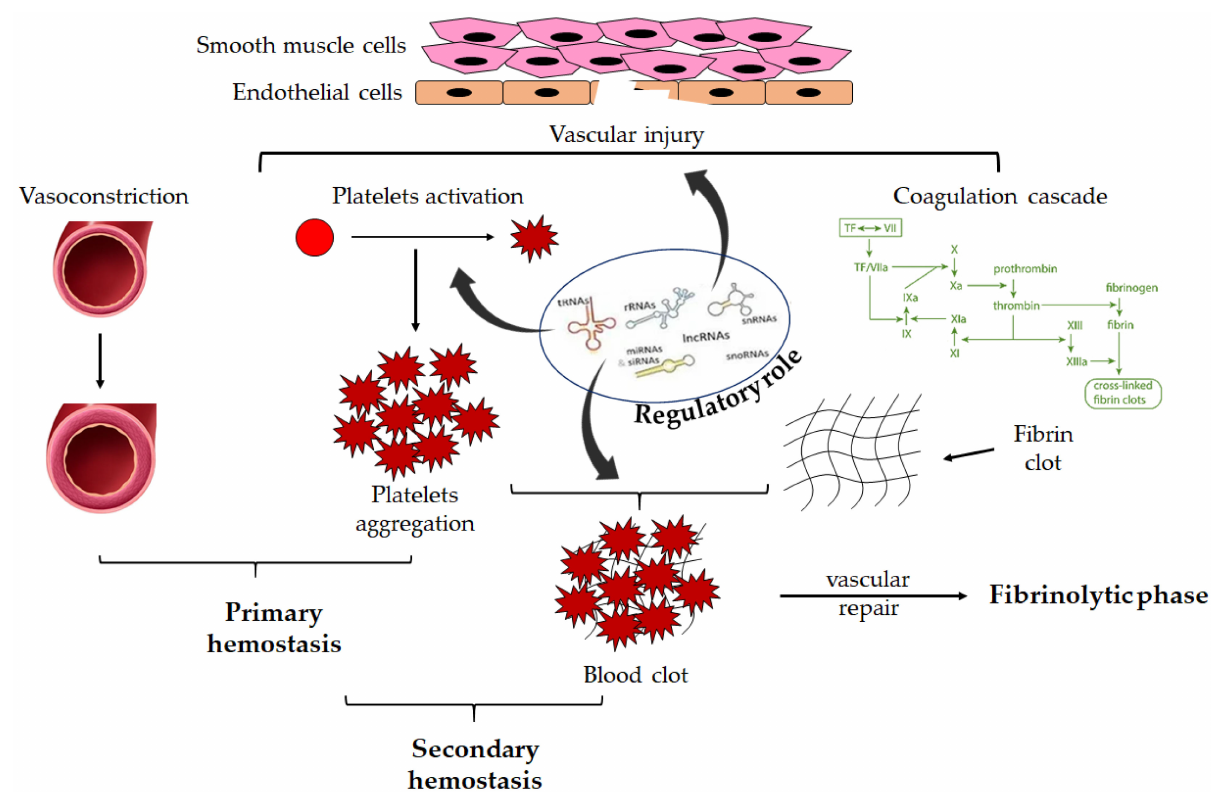
Figure 1. Overview of hemostasis. Endothelial damage induces activation of the primary hemostasis. Subendothelial thrombogenic material is exposed to the flowing blood. Vasoconstriction and coagu- lation cascade activation occur. Moreover, the subendothelial matrix proteins bind to receptors on the platelet surface finally resulting in platelet activation and aggregation, leading to platelet plug formation. Secondary hemostasis leads to the formation of fibrin through coagulation proteins and the formation of a blood clot including activated platelets. Once the vessel wall is repaired, the clot is dissolved by fibrinolysis. These processes are regulated via different RNA-related